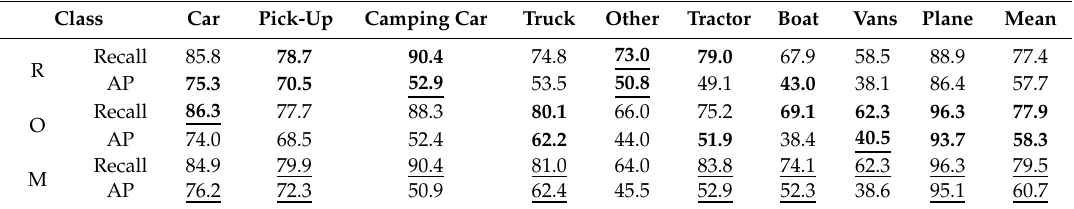
Table 6. Detection accuracy of proposed algorithm for HBB in three di ff erent types of datasets.